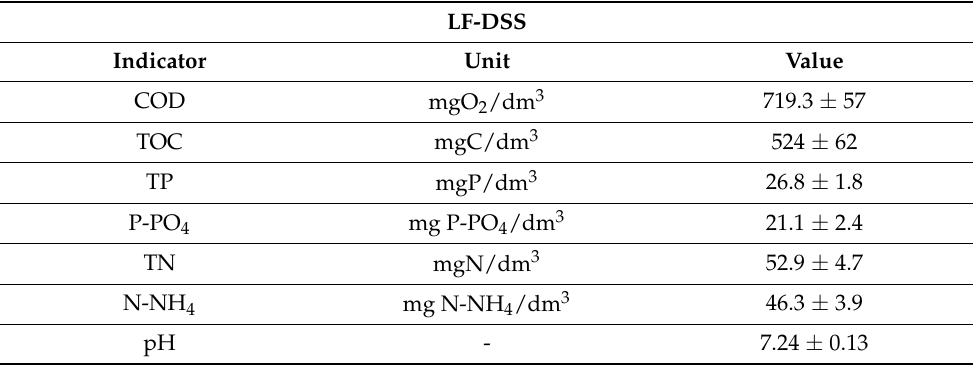
Table 1. Composition of the LF-DSS and air fed into the